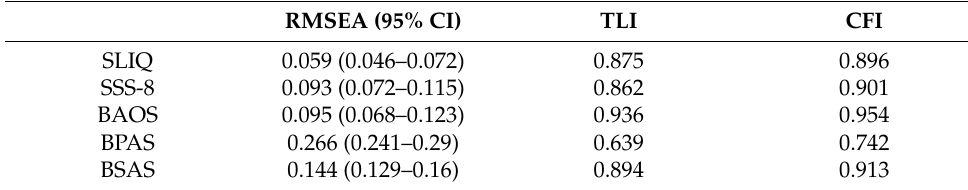
Table 2. Confirmatory factor analysis.